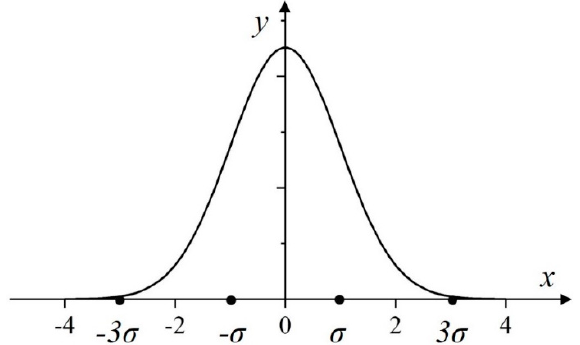
Figure 3. Probability density of the normal distribution.